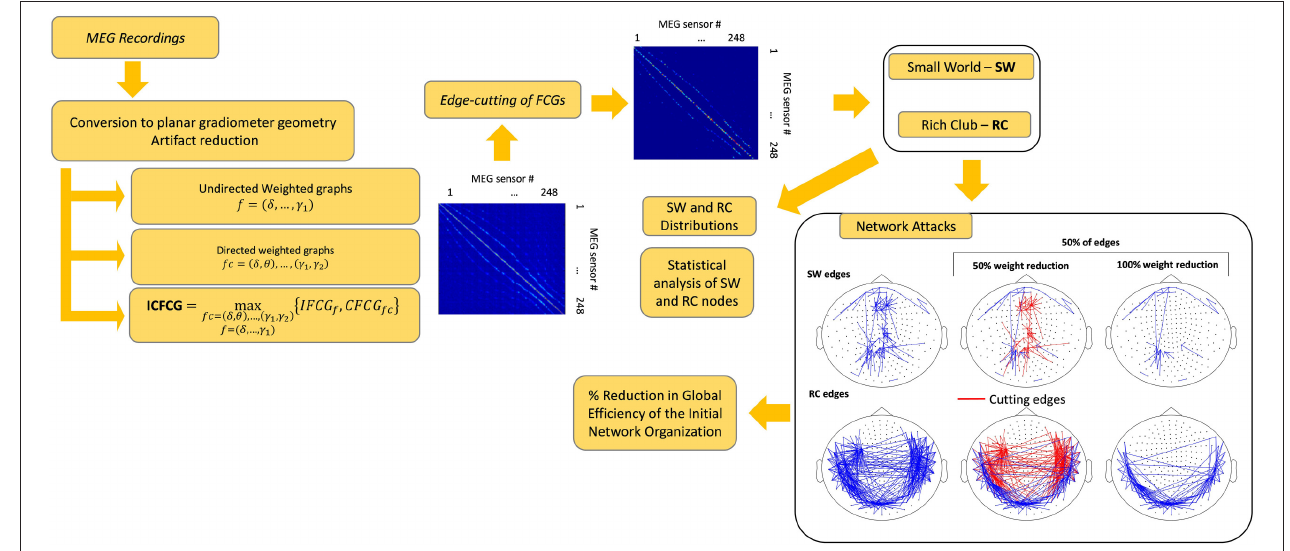
FIGURE 1 | A brief outline of the proposed analysis procedure.